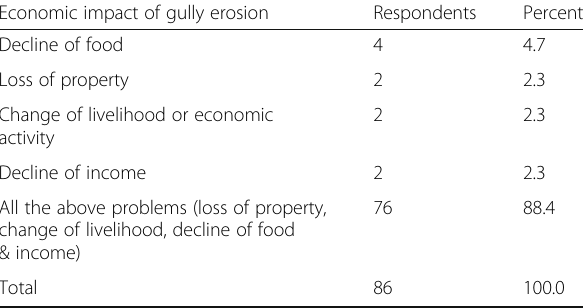
Table 10 Economic effect of gully erosion Economic impact of gully erosion